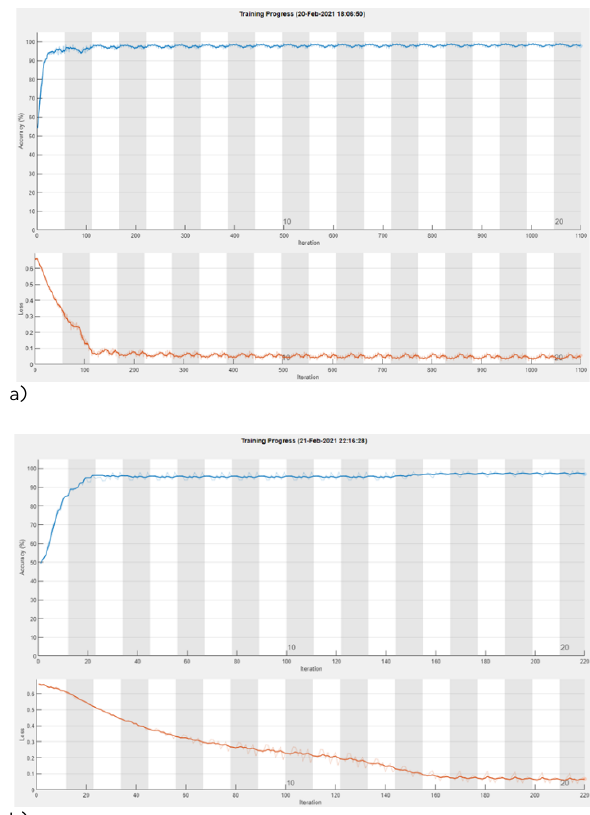
Fig. 7. TA-SegNET accuracy and loss function for data set-2: a) Training; b) Validation; c) Testing. Hyper parameters used for training the network are given in Table II. The network is trained to have the minimum and maximum accuracy value of the loss function. In order to observe the convergence of the model during the training, the accuracy and loss function changes were obtained as in Figs. 6 and 7. Phase 5 : RGB to Binary Conversion The last phase is the comparison of ground true images and segmented images obtained with TA-SegNET. Fig. 8 shows the RGB image converted to binary form and the original COVID- 19 mask for